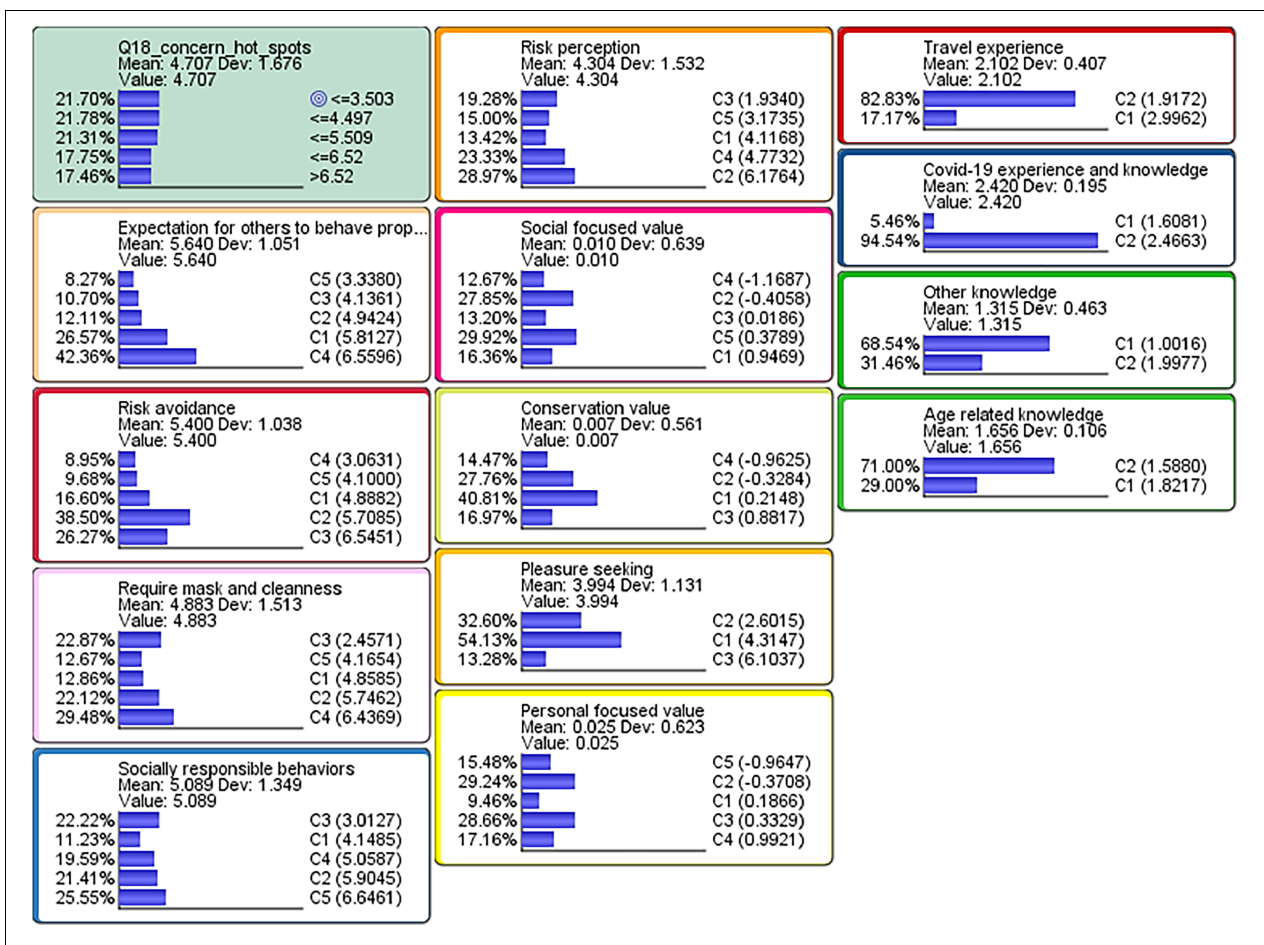
FIGURE 5 | Step 3: Joint probabilities of the respective factors (all four